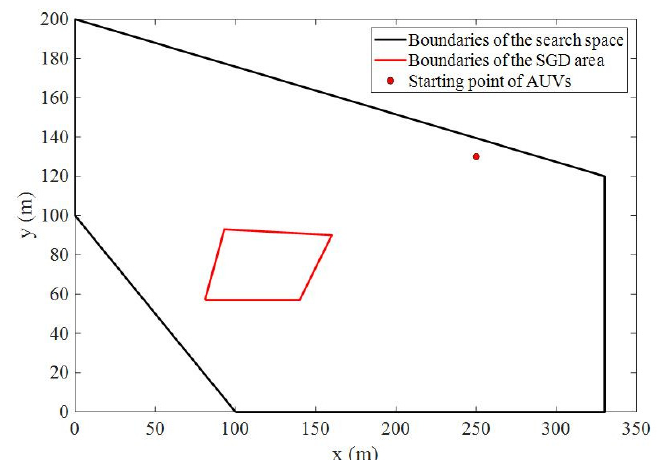
Figure 5. Overview of the search environment; boundaries of the search space (black), boundaries of the submarine groundwater discharge (SGD) area (red line), and starting point of the autonomous underwater vehicles (AUVs) (red circle).